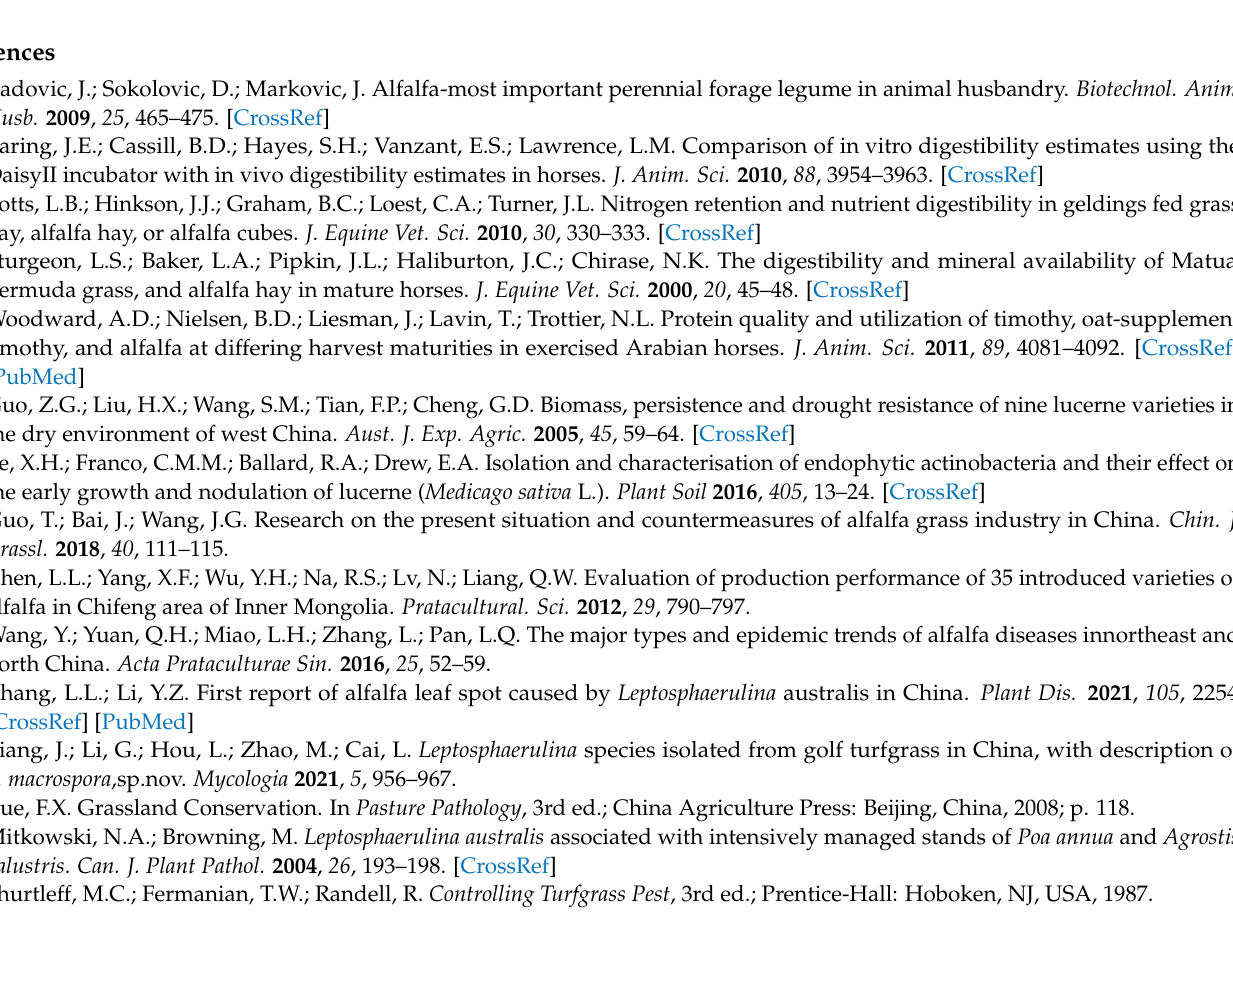
dosage in the field. Table S2: Climate information. Table S3: Survey method and investigator.